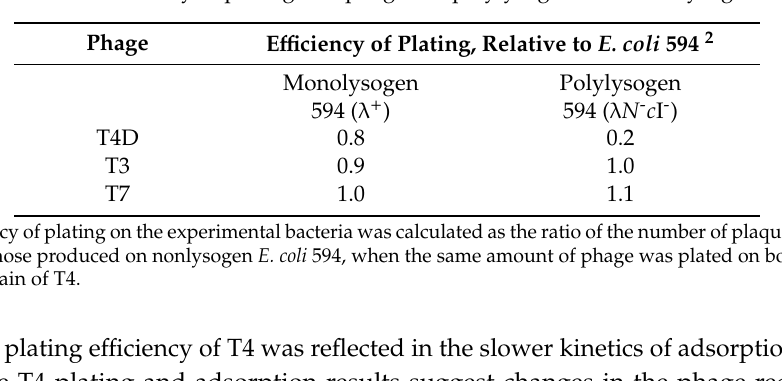
Table 3. E ffi ciency of plating of T phages on polylysogen and monolysogen.